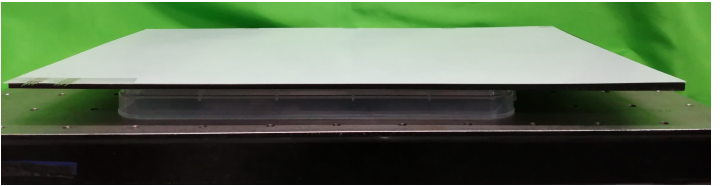
Figure 12. Stator arrangement. On an electrically-grounded metal plate, a white–translucent plastic box was placed to reduce capacitance coupling. Then, a black polyacetal plate and the stator sheet were placed on